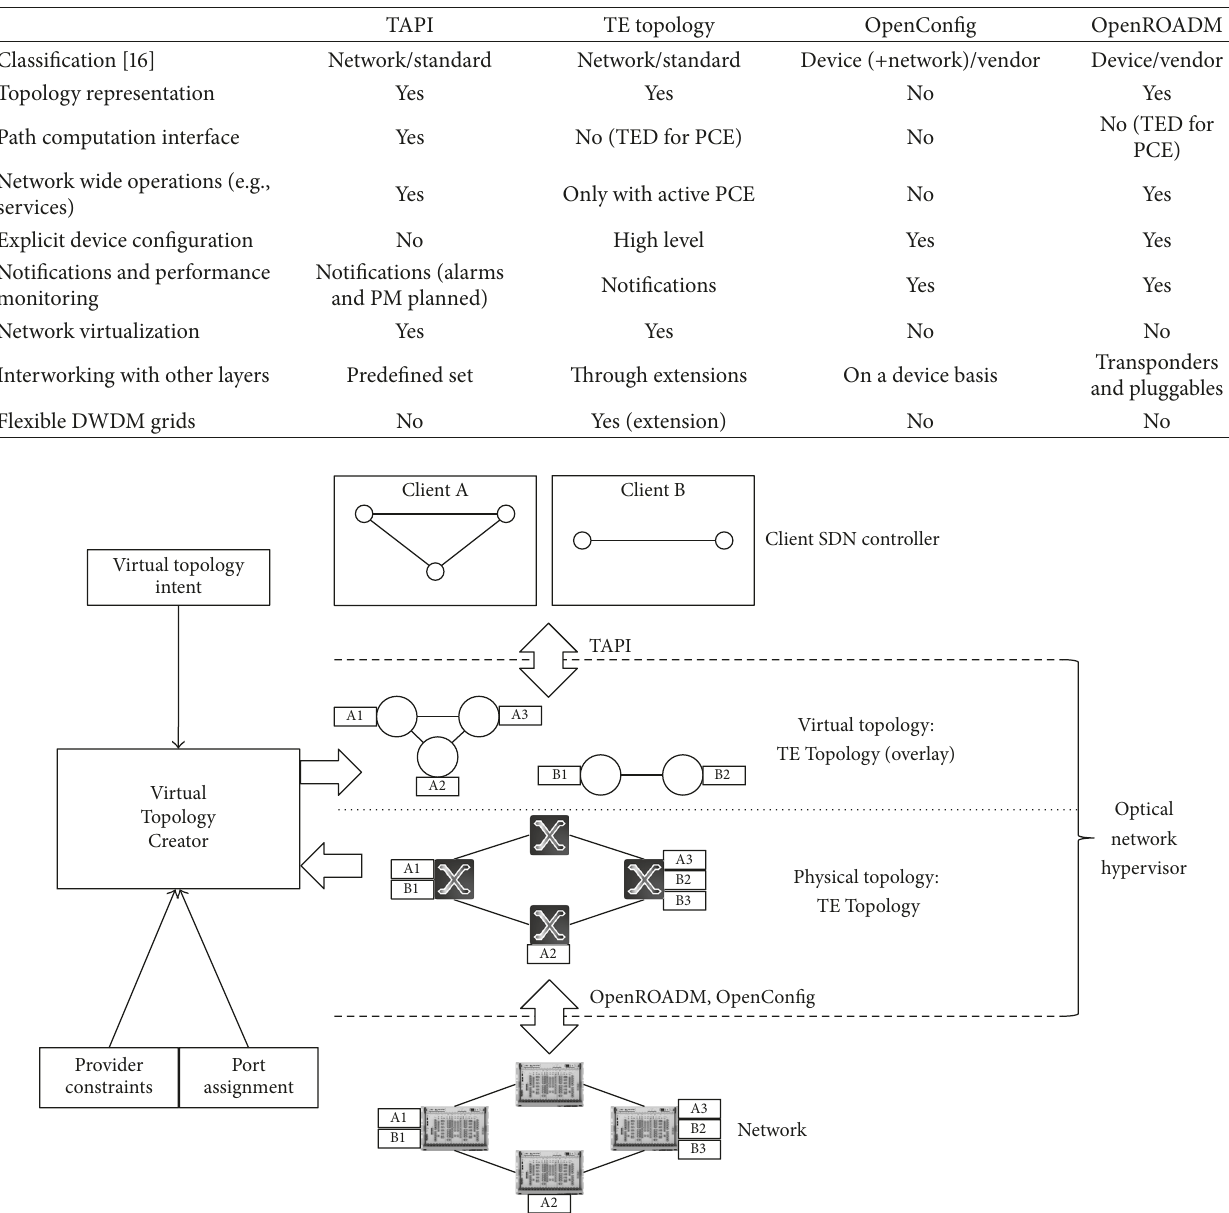
Table 2: Evaluation of the selected optical models.